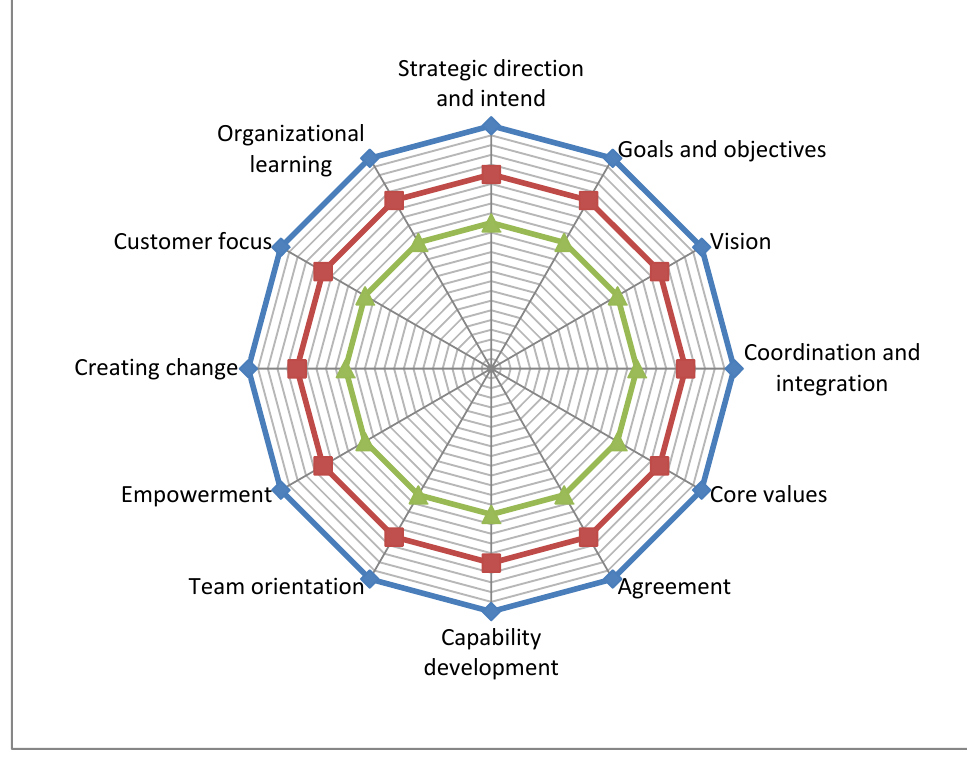
Fig. 1. The structure of Denison